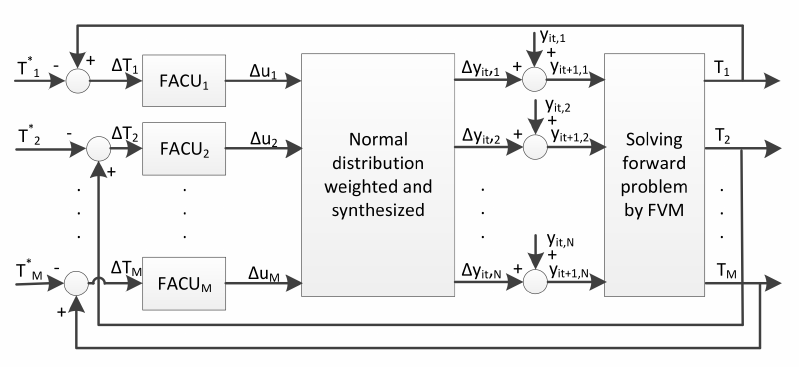
Figure 2. Decentralized fuzzy adaptive Proportion Integral Di ff erential (PID) control inversion system.